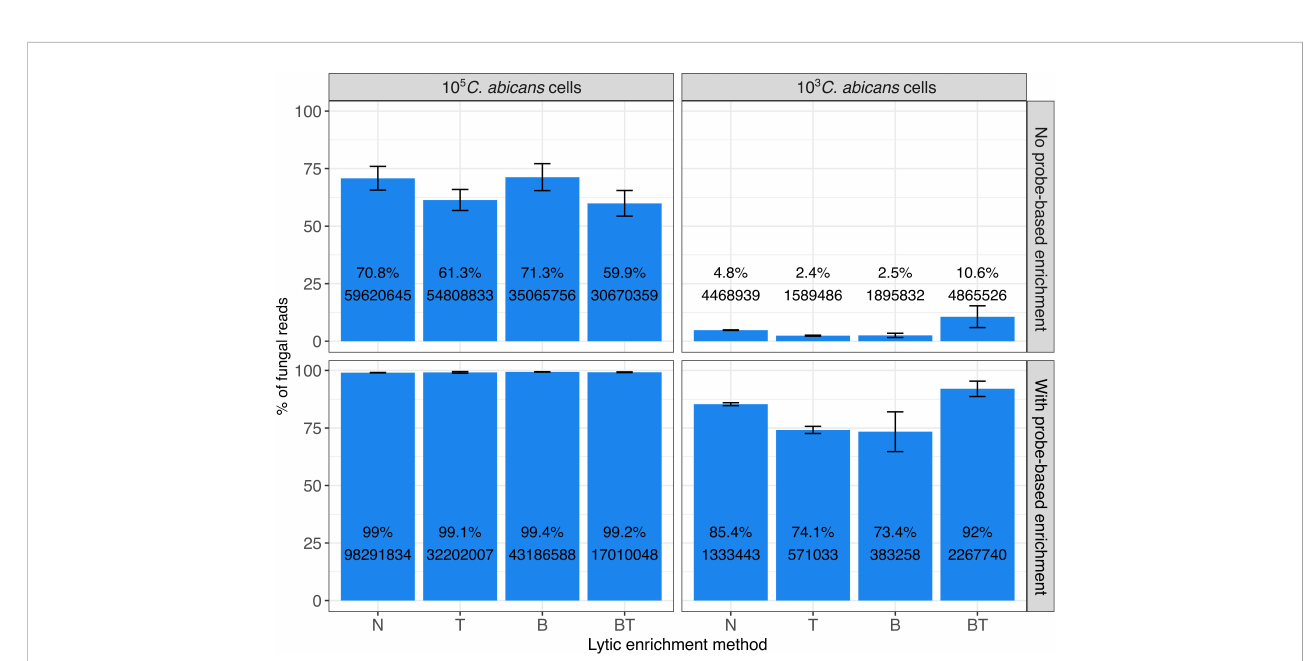
FIGURE 2 Proportions of fungal RNA reads obtained after different treatment/enrichment approaches (N, T, B, BT), and with or without probe-based enrichment, as determined by RNA-Seq. Left panel shows data of experiments with 10 5 C . albicans cells ( “ High fungal load ” ), right panel - with 10 3 fungal cells ( “ Low fungal load ” ). Upper panel shows data on experiments with no probe-based enrichment, and the bottom panel - with probe-based enrichment. N: No thiolutin and no lytic enrichment; T: Thiolutin and no lytic enrichment; B: No thiolutin and buffer RLT + b -mercaptoethanol lytic enrichment; BT: Thiolutin and Buffer RLT + b -mercaptoethanol lytic enrichment. Bars represent the proportion (in %, y axis) of mapped fungal reads over the total number of mapped reads to C . albicans and the human genomes, calculated as mean and standard deviation across three replicates. Labels on the bars represent the mean percentage (at the top) and mean raw read counts (at the bottom) across